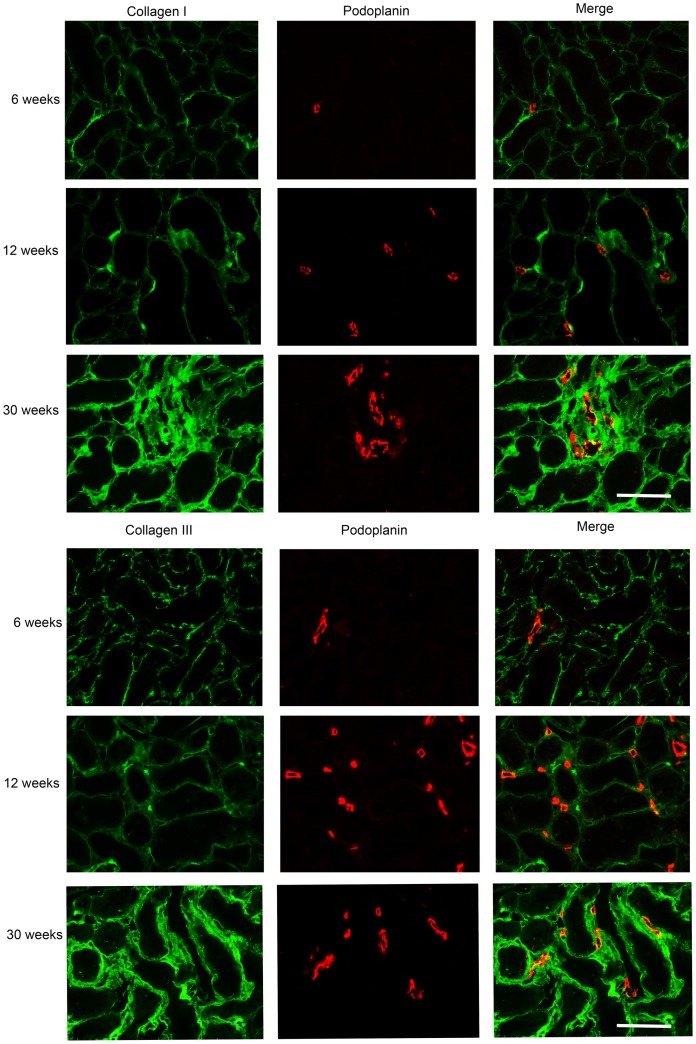
Interstitial lymph vessel induction precedes interstitial fibrosis.Double staining of podoplanin (lymph vessels) with the interstitial collagens types I and III shows the induction of lymph vessels from 12 weeks onwards, whereas interstitial fibrosis is only evident at week 30. (Bar = 100 µm).